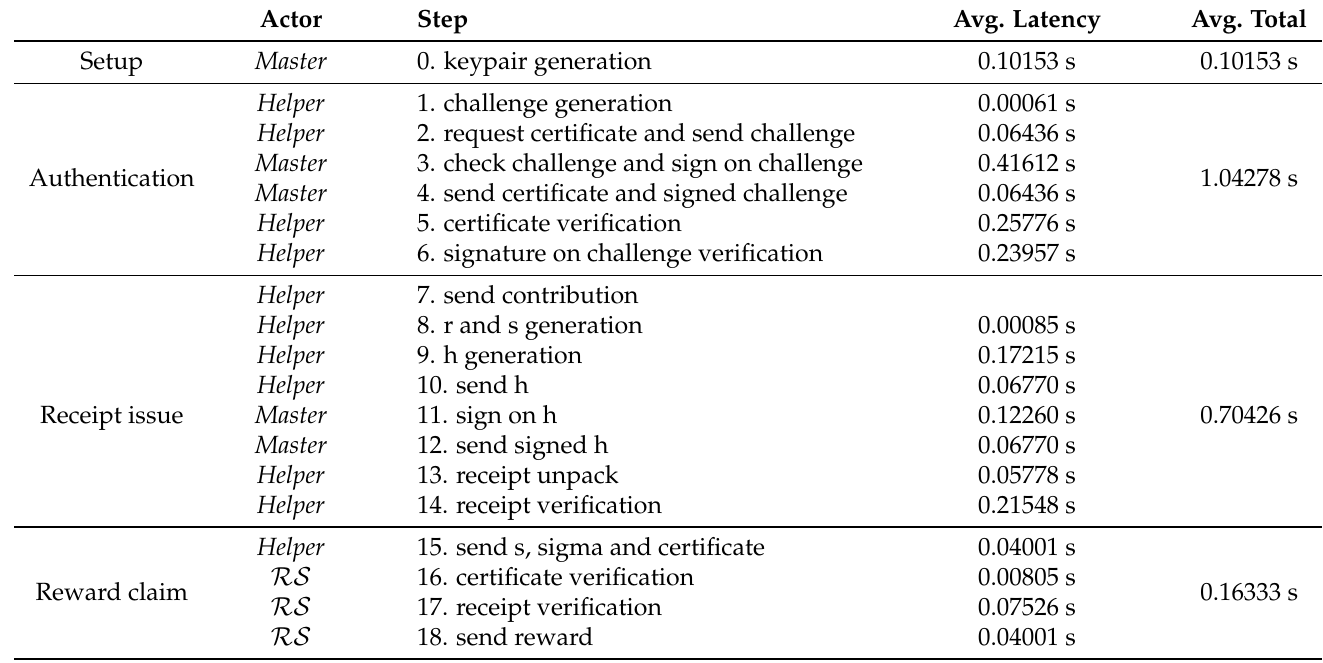
Table 2. Table of